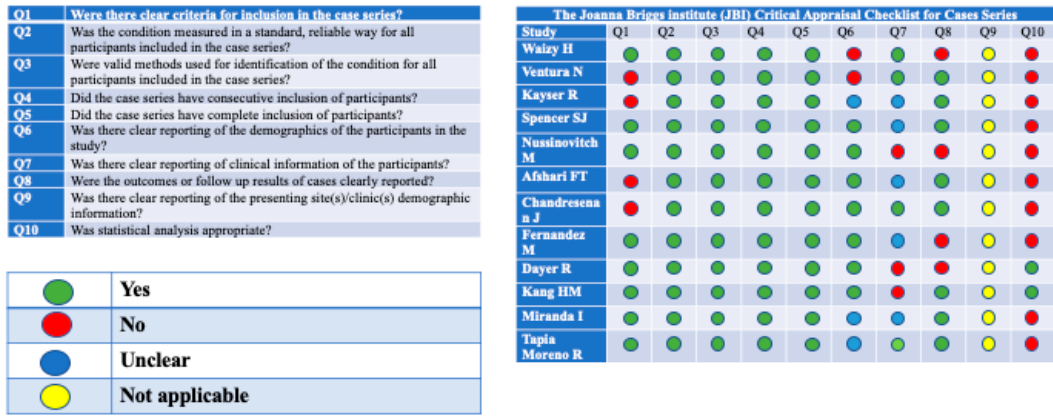
Figure 3. Quality assessment of the included studies. The Joanna Briggs Institute (JBI) Critical Appraisal Checklist for Case Series.